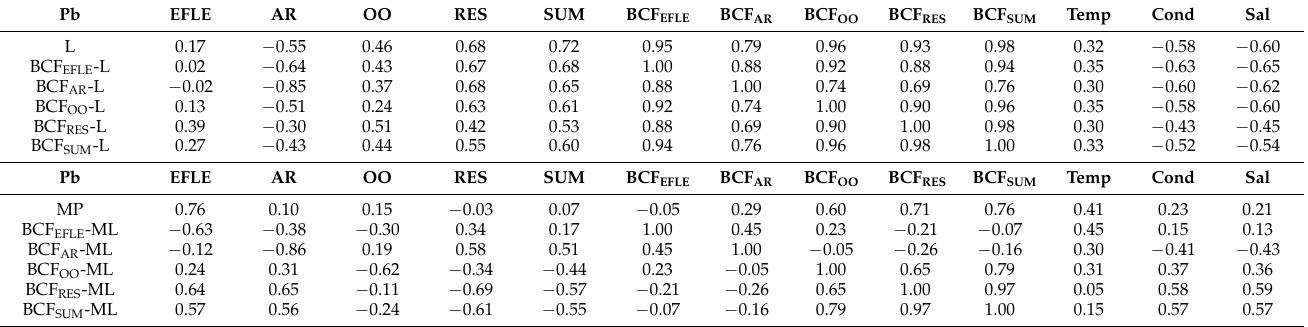
Table 6. Lead correlation coefficients between variable A (Pb levels in the lamina (L), midrib plus petiole (MP), and Pb bioconcentration factors (BCF)) and variable B (geochemical fractions in the sediments and surface water parameters). Values in red are significant at p <